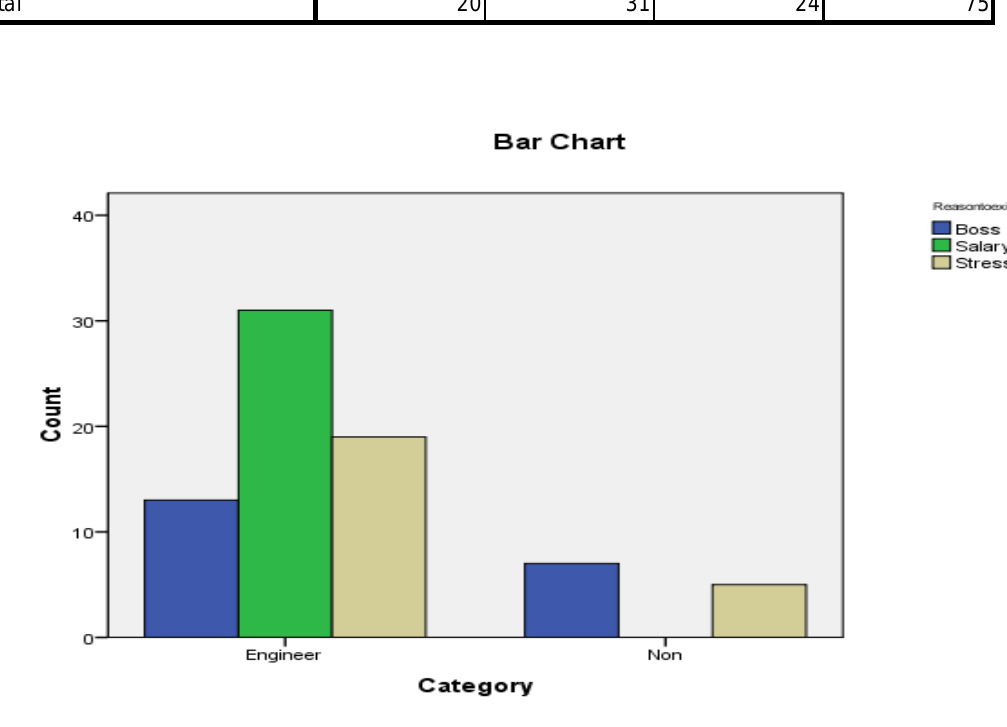
Fig 1: Response in Bar